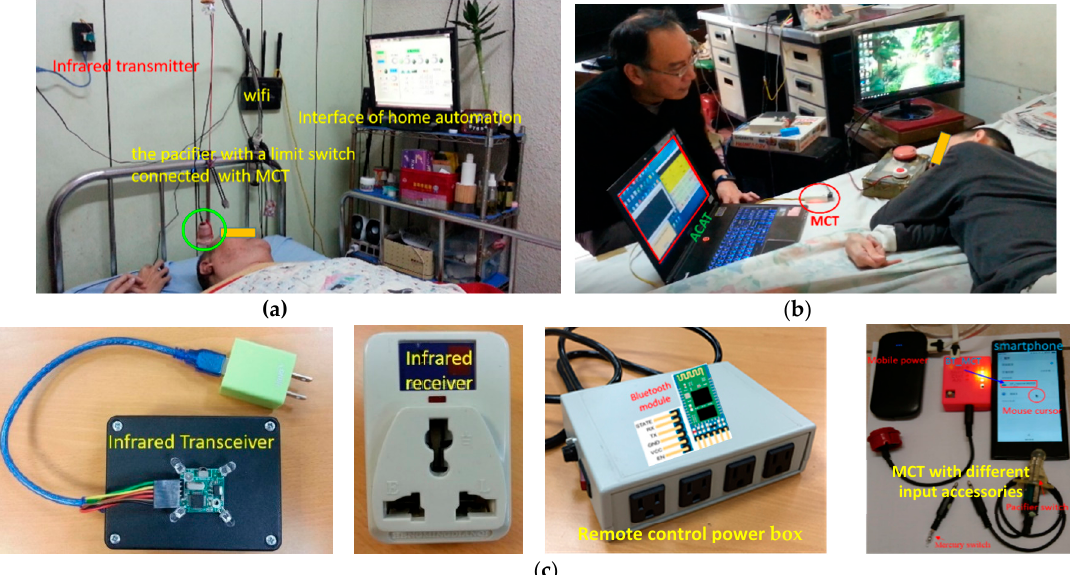
Figure 11. The real situations of two severely disabled subjects manipulating home automation and Intel ACAT platform with the help of MCT, ( a ) Home automation; ( b ) Intel ACAT; ( c ) The related hardware (Arduino chip, wirelessly controlled power box, Bluetooth and infrared transceiver, etc.) and assistive input accessories used in WHAS.